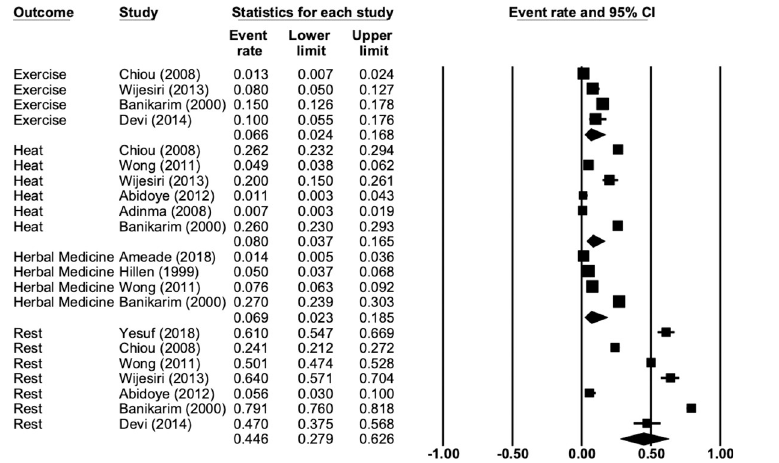
Fig 5. Traditional, complementary or non-pharmacological intervention